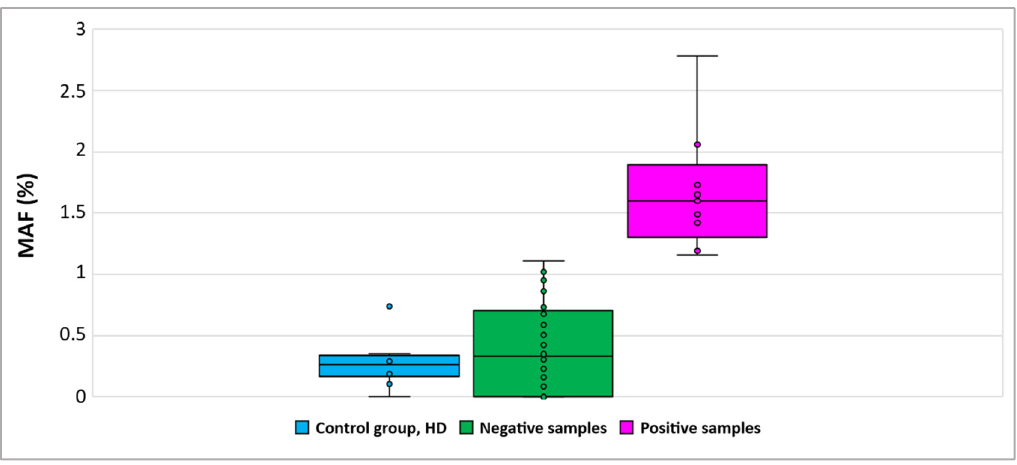
Figure 2. Detection of ESR1 mutations in primary tumor samples using drop-off ddPCR. (MAF: mutant allele frequency).